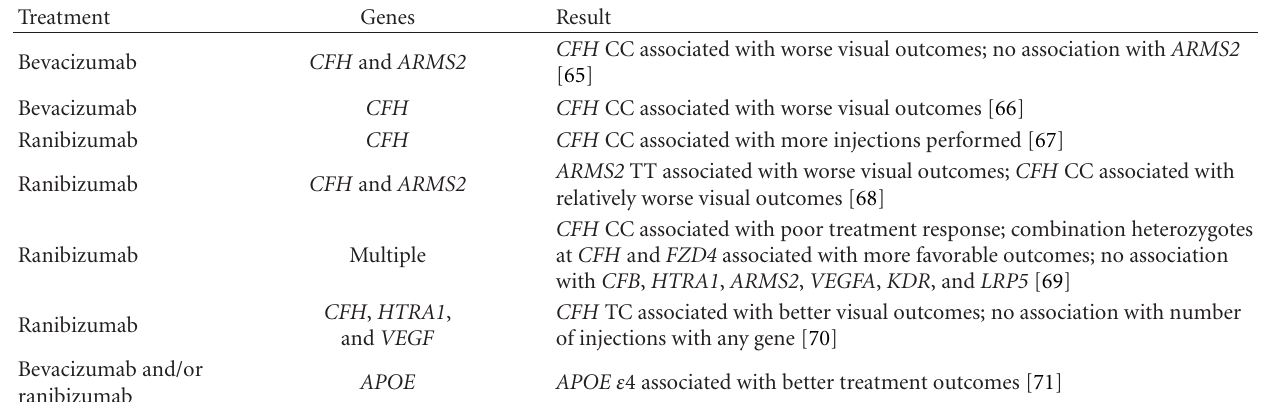
Table 3: Pharmacogenetics of antivascular endothelial growth factor